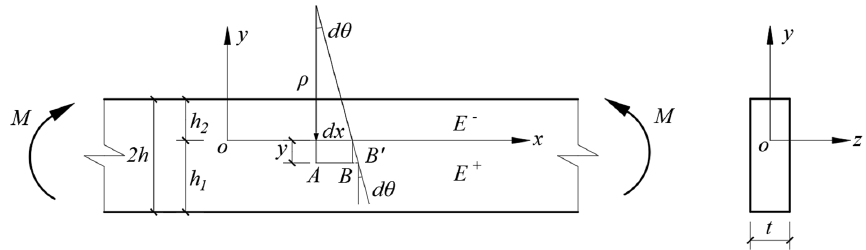
Figure 4. Pure bending of a bimodular bar with rectangular section.